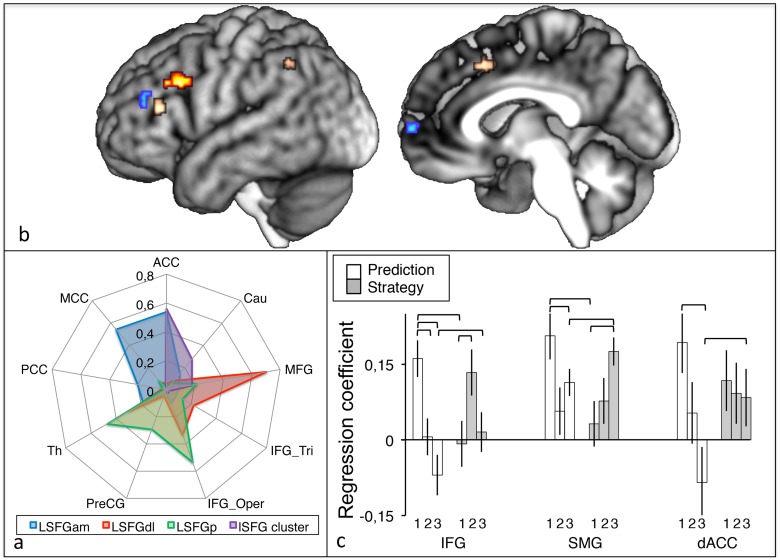
Anatomical and functional connectivity of the left SFG cluster.(a) Radar plot of top targets for SFG sub-regions using data reported by Li et al. [40] (blue: lSFGam, red: lSFGdl, green: lSFGp) and our own analysis of the lSFG cluster reported here (purple). ACC: anterior cingulate cortex, Cau: caudate, MFG: middle frontal gyrus, IFG_Tri: inferior frontal gyrus pars triangularis, IFG_Oper: inferior frontal gyrus pars opercularis, PreCG: precnetral gyrus, Th: thalamus, PCC: posterior cingulate cortex, MCC: middle cingulate cortex. (b) Surface renders of significant experimental effects on functional connectivity (hot scale: increased for Prediction vs. Strategy, cold scale: increased for Strategy vs. Prediction, tangerine: Task x Time interaction). (c) Regression coefficients for the Task x Time interaction with significant post-hoc comparisons indicated by brackets.